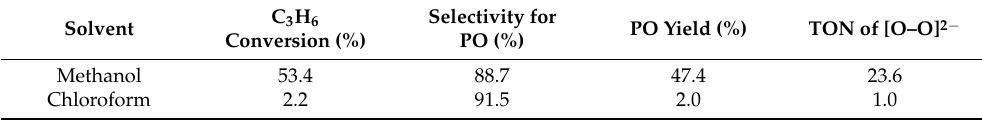
Table 4. Results of catalytic propylene epoxidation by O 2 over Pd-PW-HAP in various solvents 1 .